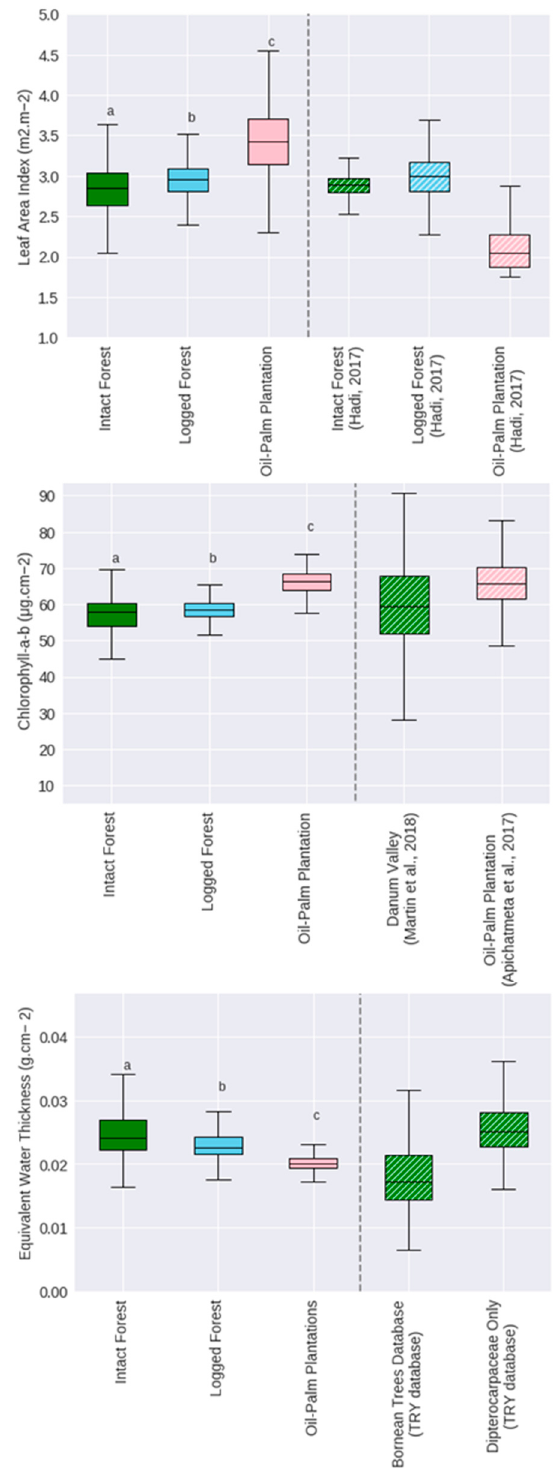
Figure A3. Comparison of the retrieval of spectral trait indicators from SNAP’s biophysical processor derived from Sentinel-2 reflectance spectra to relevant in situ trait ranges in the TRY plant trait database [89,90] and other regionally relevant field campaigns [64,86,88,131]. Differences in retrieved trait estimates between land-use types according to a post hoc Tukey’s HSD test are indicated with different annotated letters (a, b, c).